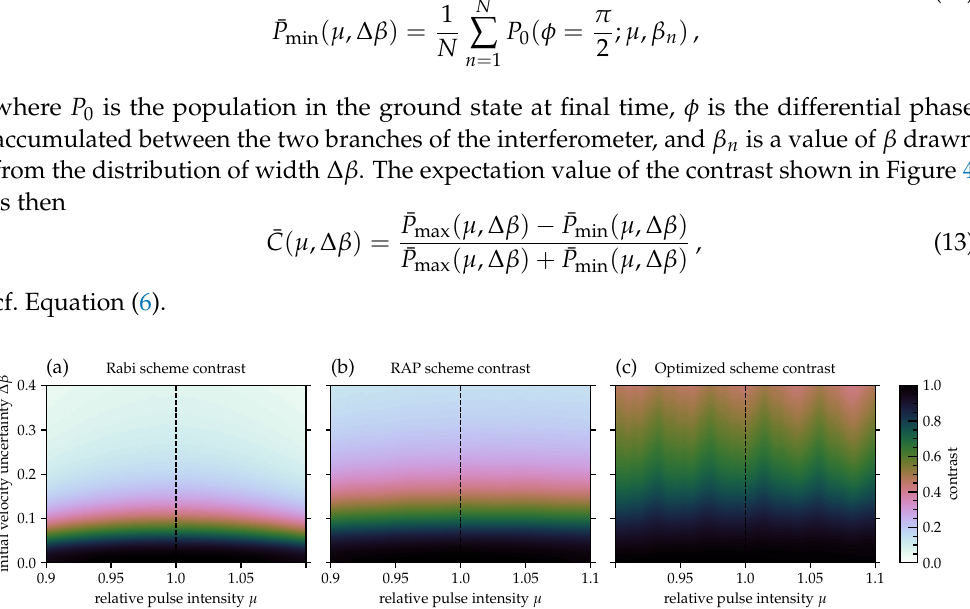
Figure 4. Contrast achieved with both analytical and optimized pulse schemes for a full 20¯ hk interferometer scheme. In each panel, the expectation value of the signal contrast is shown for a fixed amplitude scaling factor µ of the ideal pulse amplitude, and assuming a Gaussian distribution with width ∆ β for the atom’s initial momentum relative to the rest frame in units of 2¯ hk . The schemes are ( a ) a train of π /2 and π Rabi pulses, ( b ) a combination of π /2 and π pulses with rapid adiabatic passage (RAP), and ( c ) a scheme using optimized control pulses in combination with rapid adiabatic passage, cf. Figures 2, 3 and 7. The value of the contrast for each point is obtained from the average populations in the ground state, see Equation